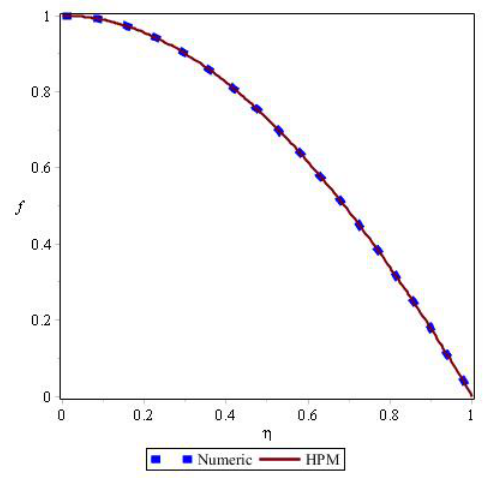
Figure 8. Comparison between the obtained solutions for f HPM and Numerical Method ( A ∗ = 1 , Ha = 0 , Re = 50 , α = 1 ◦ , φ = 0 ).